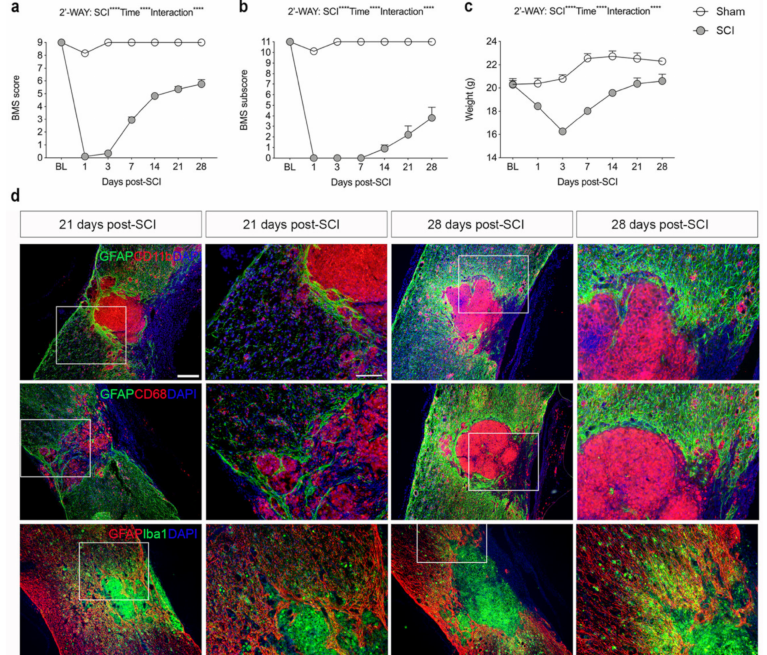
Figure 1. Analysis of locomotor function and glial reactions after SCI. ( a ) Evaluation of hind limb locomotor function. SCI and sham mice were tested 1, 3, and 7 days after surgery and weekly thereafter for 28 days. Motor behavior was scored under blinded conditions with the Basso Mouse Scale (BMS). Analysis of sham and SCI mice showed significantly lower BMS scores in SCI mice compared to